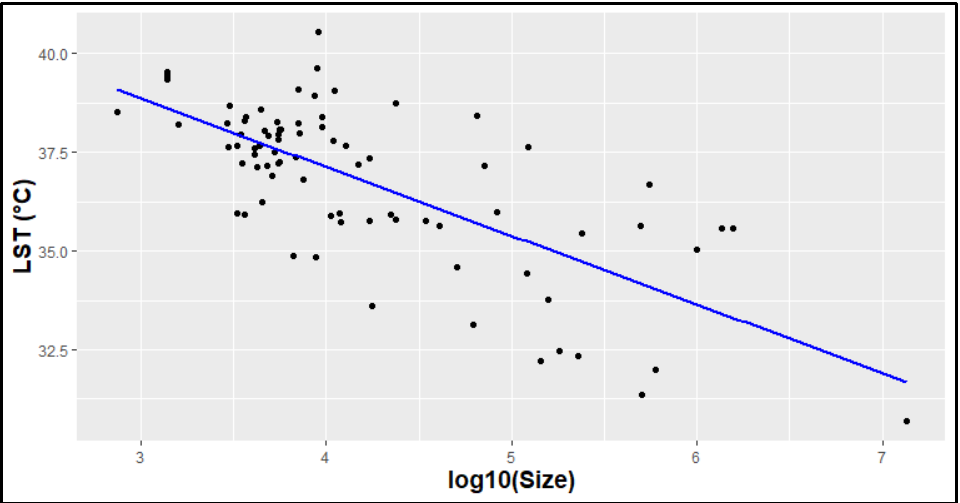
Figure 13. Log-linear regression of size of 80 UGSs and land surface temperature (LST).